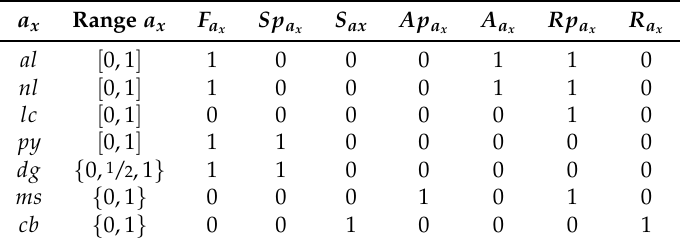
Table 3. Summary of all possible adaptations used by the emotional model. For each of the adaptations, the value of the constants defines the presence of the emotions in the equation. a